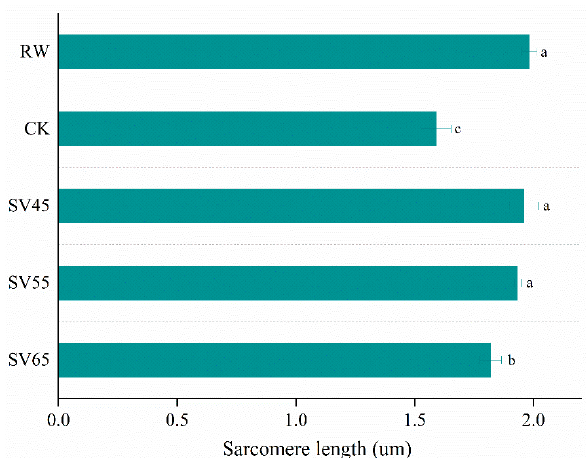
Figure 7. Sarcomere length (B) of beef semitendinosus from RW, CK and SV sample. a–c Different letter indicates statistically significant differences ( p < 0.05, n = 50).